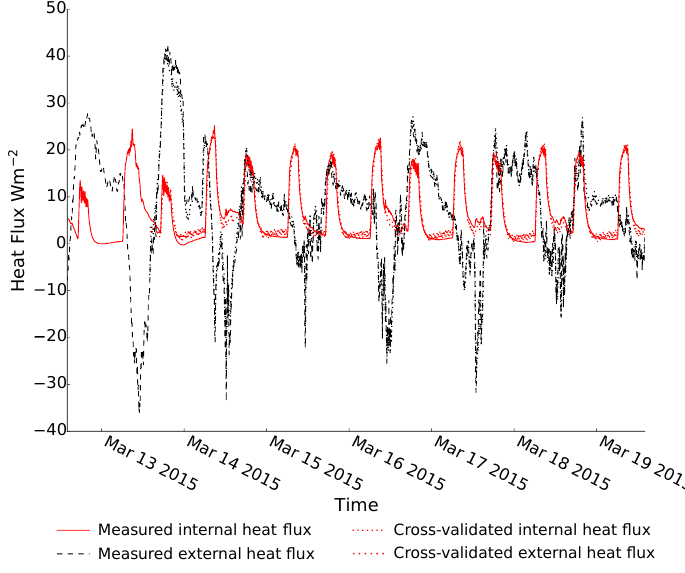
Figure 8. Measured and cross-validated (using the 2TM model) heat flux time series for the